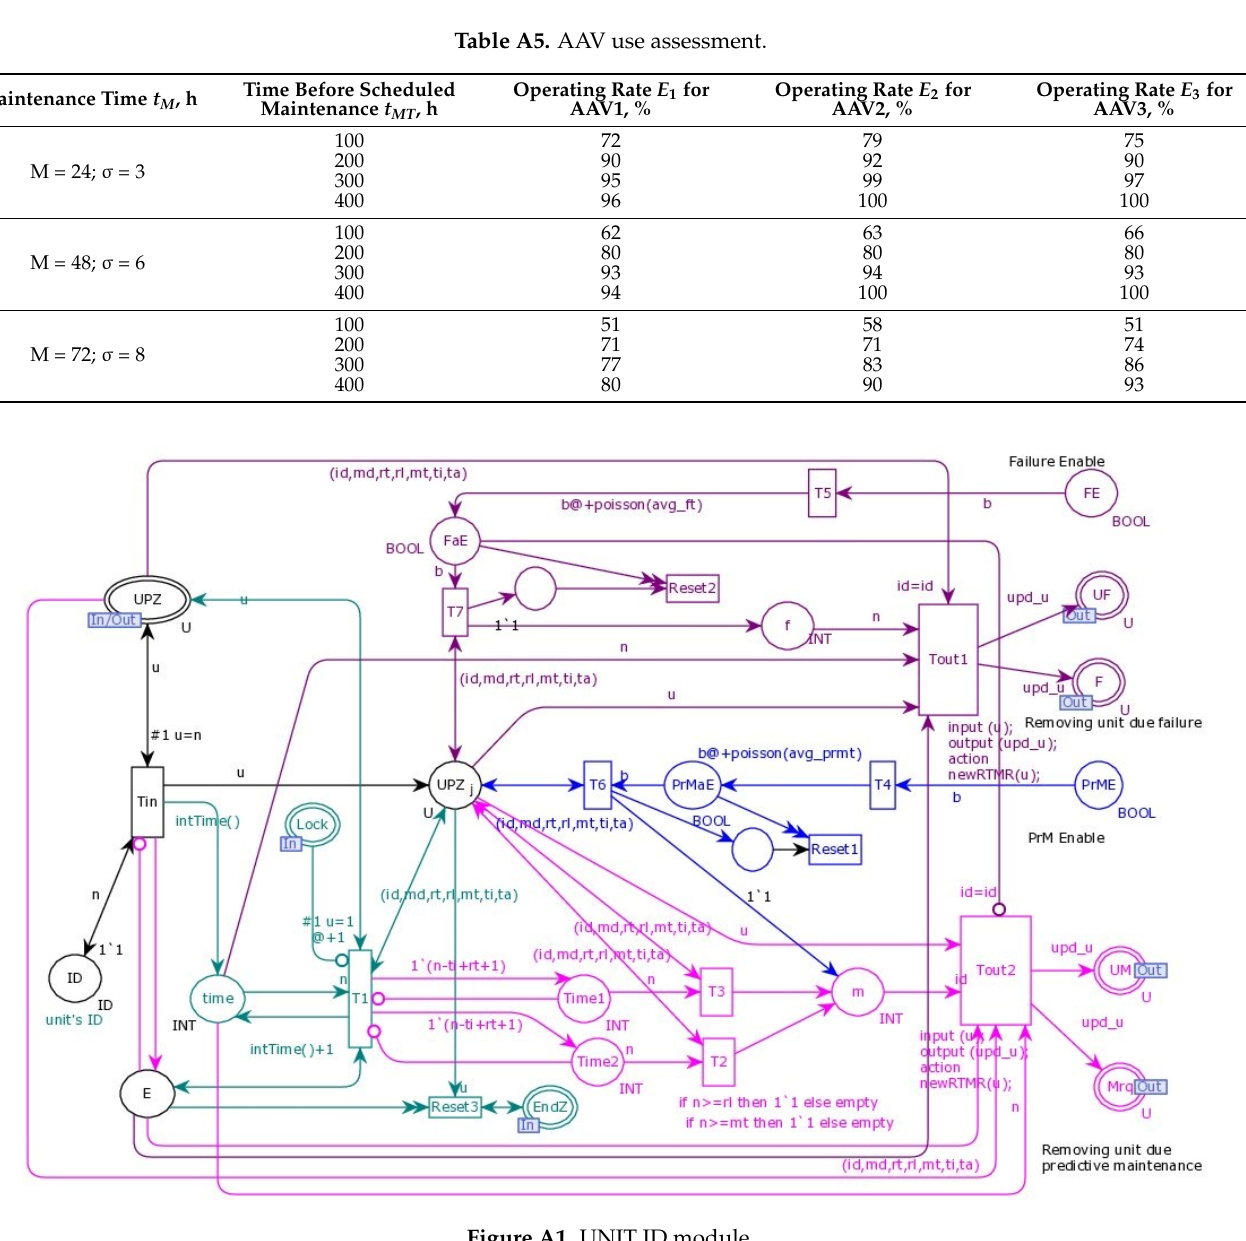
Table A5. AAV use assessment.